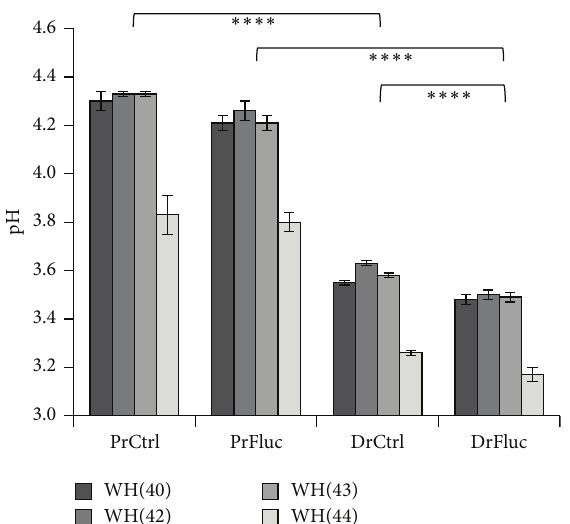
Figure 3: Mean ( ± SE) soil water pH in different experimental groups at different phases of the study. 𝑁 = 5 for each experimental group and each phase. pH values were converted to H + concen- trations (mol H 3 O + L −1 ) before the statistical analysis. Significant differences between the experiment groups are indicated with asterisks ( ∗∗∗∗ 𝑃 < 0.0001 ). W: water sampling; H: high water table; (xx): calendar week number. Pr: pristine; Dr: drained; Ctrl: control; Fluc: fluctuating water